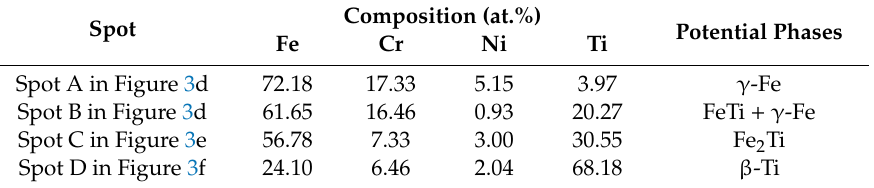
Table 4. The cross-sectional spot energy disperse spectroscopy (EDS) analysis of 301L/TA2 welded joints. Spot